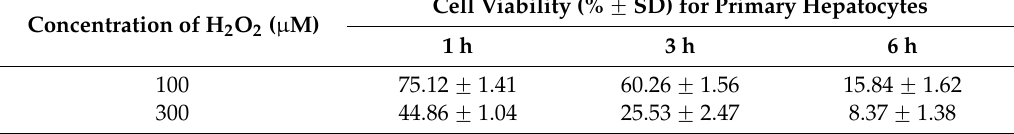
Table A1. Effect of concentration and exposure time of H 2 O 2 on the percentage cell viability of human primary hepatocytes.